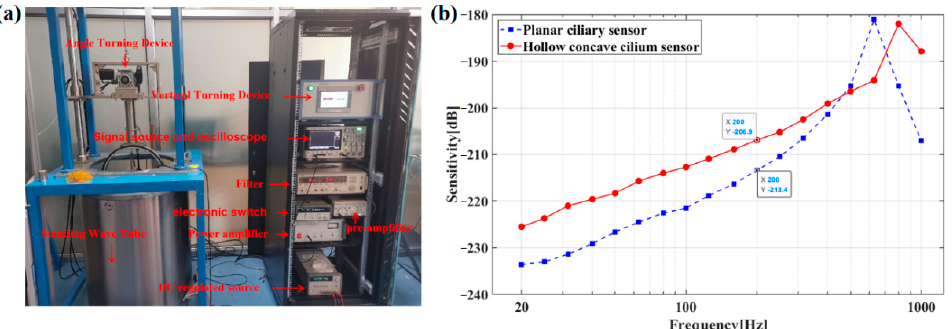
Figure 15. ( a ) Calibration system for the standing-wave tube. ( b ) Sensitivity curves of MEMS cardiac sound sensor with integrated planar cilium and with integrated hollow concave cilium.